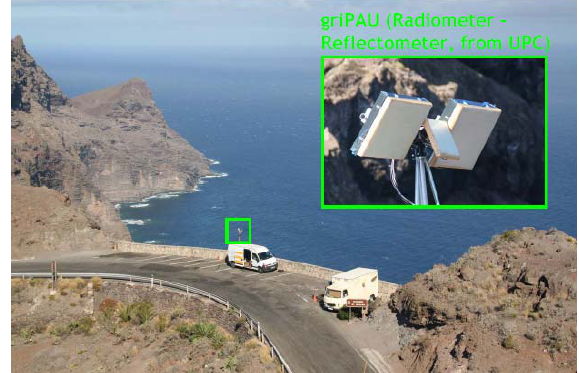
Figure 14. griPAU deployed during the ALBATROSS 2009 field experiment.